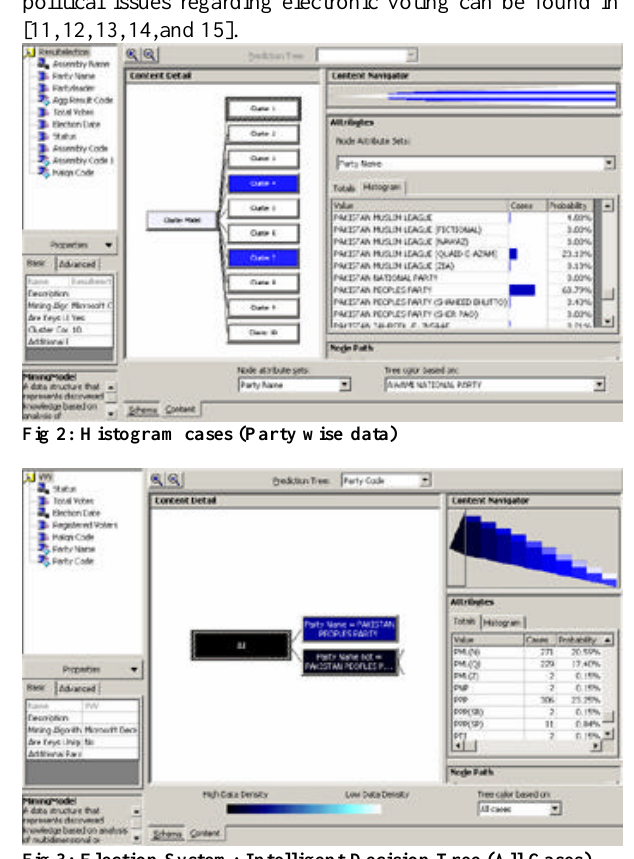
Fig 3: Election System: Intelligent Decision Tree (All